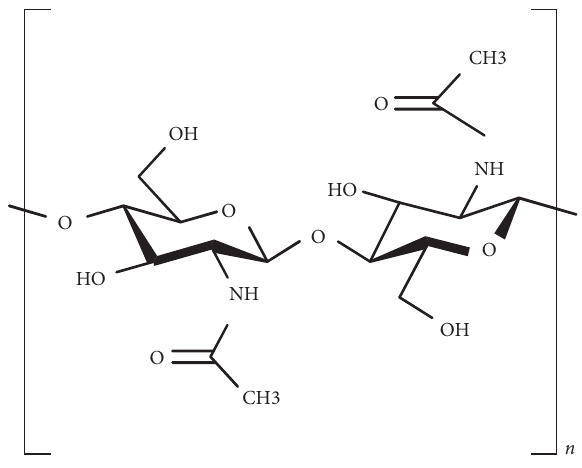
Figure 1: Chemical structure of